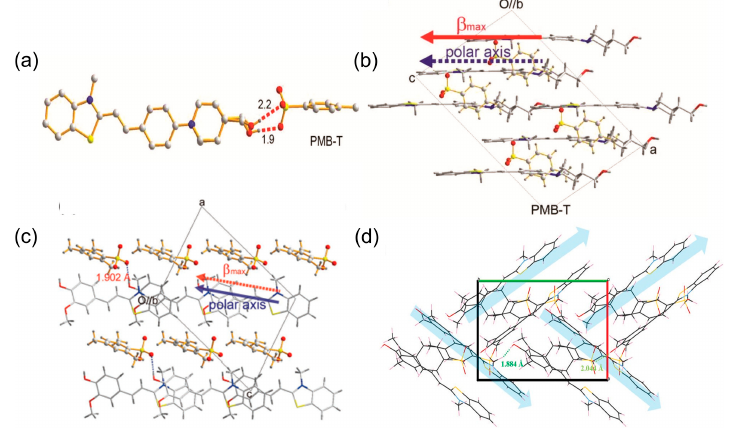
Figure 10. ( a ) Interaction between the anion and cation of PMB-T; ( b ) packing of PMB-T along the b -axis [46]; ( c ) packing of HMB-TMS along the b -axis [47]; and ( d ) crystal packing diagram of HDB-T crystal [48].